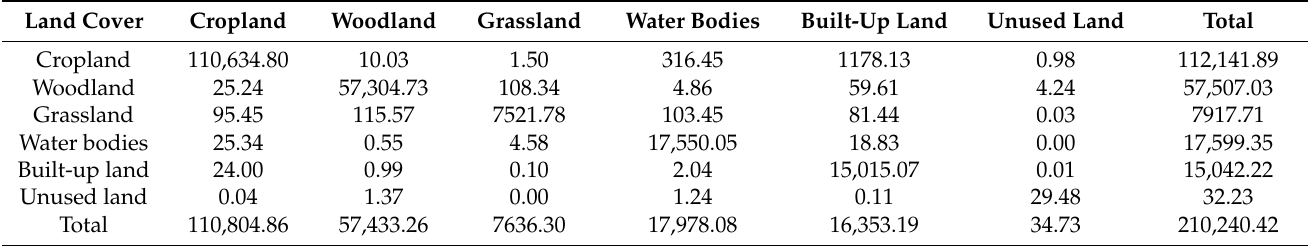
Table 3. Land conversion in Yangtze River Delta Region (1995–2000) (area: km 2 ). Land